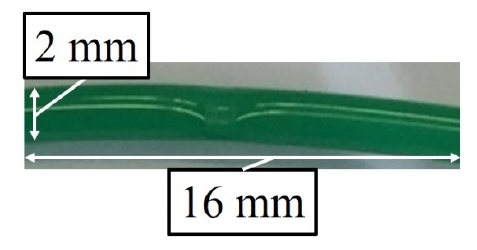
Figure 17. Pinched elastic tube.